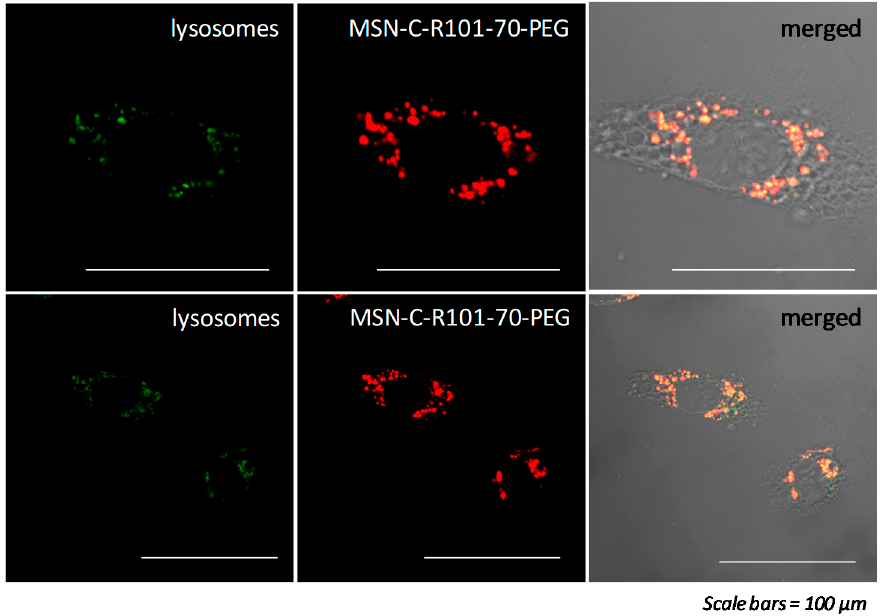
Figure 6. Fluorescence images of MSN-C-R101-70-PEG internalized into lysosomes of HeLa cells. Images show lysosomes (green- left ), rhodamine 101 from MSN-C-R101-70-PEG (red- middle ), and merged fluorescence of lysosomes and rhodamine 101 (yellow- right ). Scale bars 100 μ m.